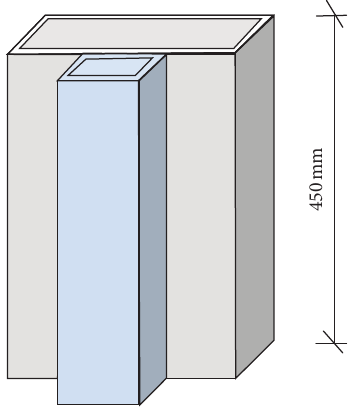
Figure 1: 3D schematic of specimen.